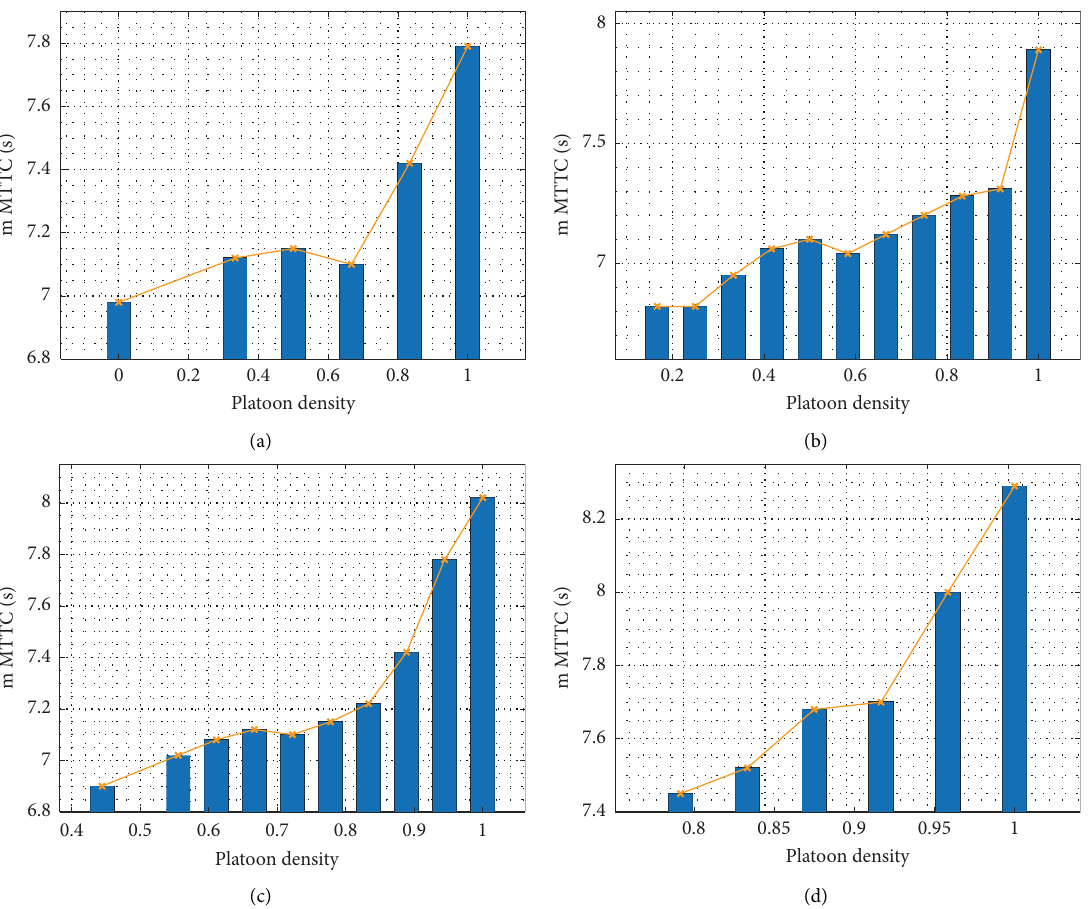
Figure 9: System-level MTTC means’ column-line charts at four penetration rates: (a) p � 0 . 2, (b) p � 0 . 4, (c) p � 0 . 6, and (d) p � 0 .